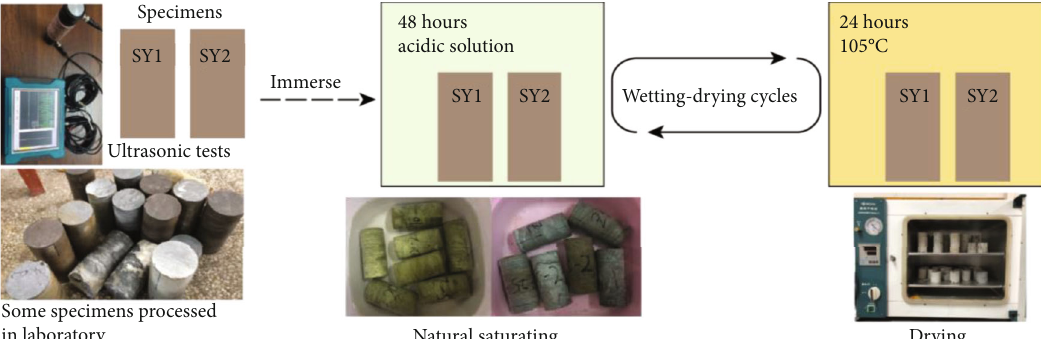
Figure 1: The process of the wetting-drying cyclic test.